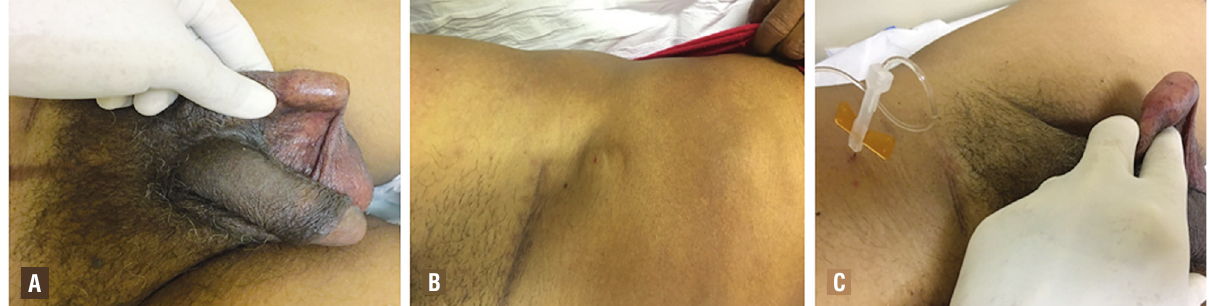
CFigure 4 - Aspect of the sphincter BR-SL-AS 904 (Pump), activation valve (B). Surgical stitches were removed on the tenth postoperative day and the device activated on the thirtieth day by infusing 15 ml of distilled water into the system by the activation valve (C).